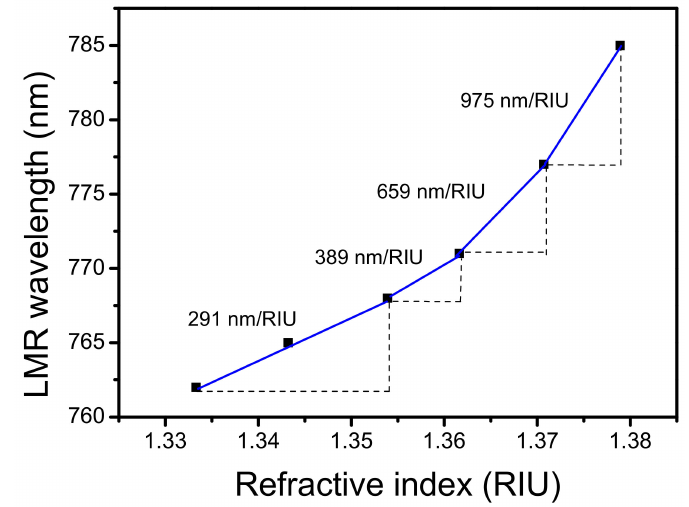
Figure 6. Lossy mode resonance (LMR) wavelength compared to the refractive index (RI) of the glucose solution and